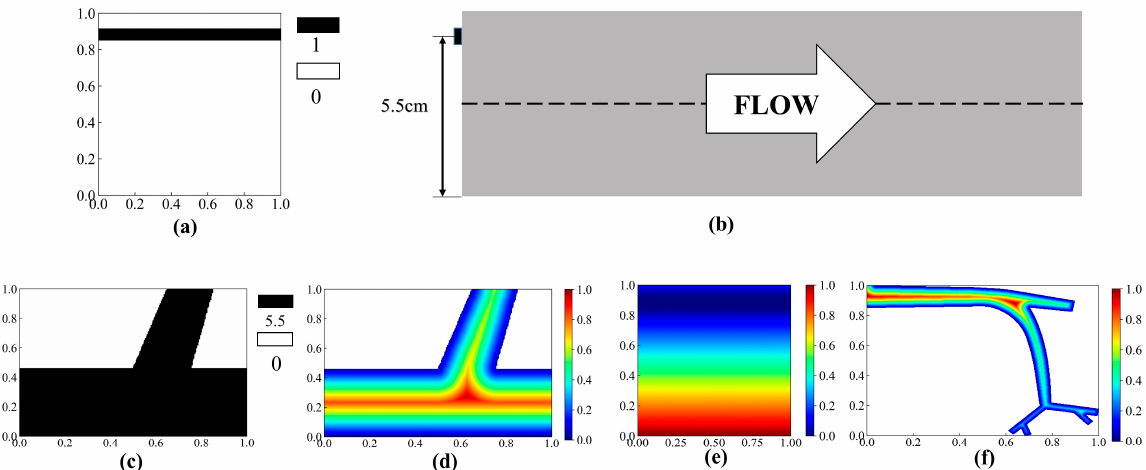
Figure 3. ( a ) Binary representation of the injection site; ( b ) binary representation of the bifurcation vessels and the injection site; ( c ) SDF representation of the bifurcation vessels and the injection site; ( d ) SDF representation inside the bifurcation vessels; ( e ) SDF representation of the injection location; ( f ) SDF representation of the hepatic artery system.